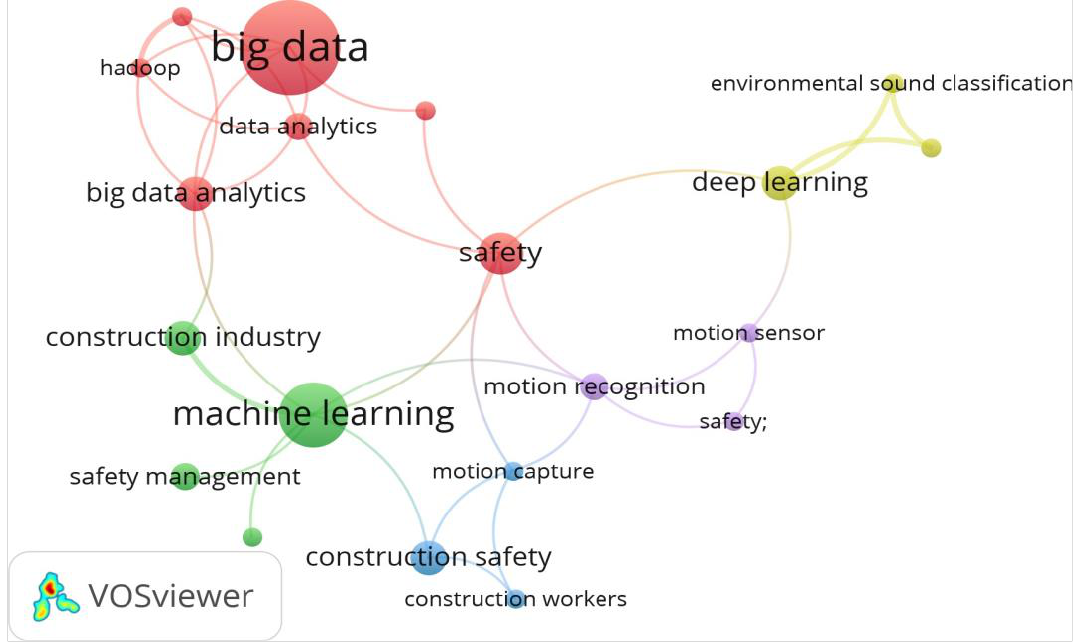
Figure 2. Keywords co-occurrence map of references.